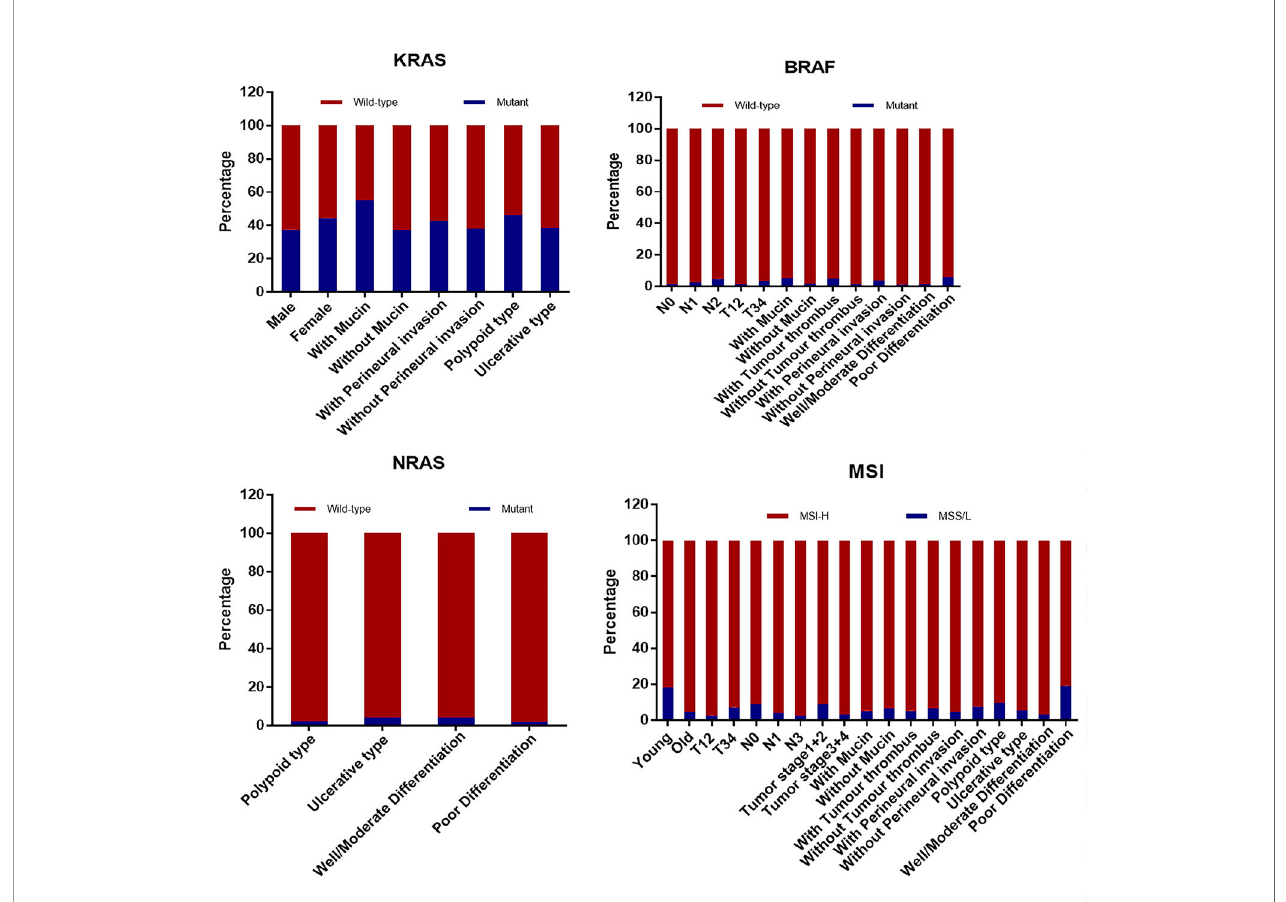
FIGURE 3 | The correlation between clinicopathological characteristics and molecular markers that shows statistically signi fi cant difference. KRAS mutation more commonly occurred in female patients with a mucinous, perineural invasive, and polypoid tumor while NRAS mutation is more associated with well-differentiated ulcerative tumors. BRAF mutation was more relevant to lymph node involvement, deeper in fi ltration of the bowel wall, mucinous, a poorly-differentiated tumor with thrombus, and perineural invasion. MSI-H was more commonly found in younger patients with deeper bowel wall in fi ltration and a poorly-differentiated polypoid